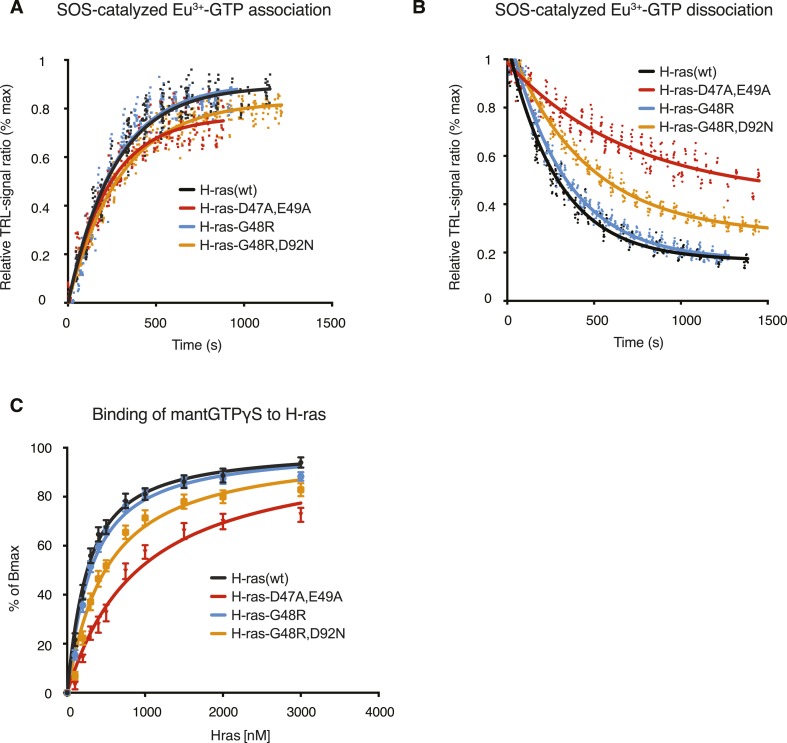
SOS-mediated nucleotide exchange kinetics, as well as mantGTPγS dissociation constants of wt H-ras and mutants.SOS-induced Eu3+-GTP association (A) and dissociation (B) kinetics with wt H-ras (black), H-ras-D47A,E49A (red), H-ras-G48R (blue), and H-ras-G48R,D92N (orange) monitored using the quenching resonance energy transfer (QRET) technique. Dots represent data points obtained from individual reactions, with a total of 360 individual data points for each H-ras. (C) Fluorescence anisotropy binding data for the derivation of dissociation constants (Kd) between mantGTPγS and wt H-ras (black), H-ras-D47A,E49A (red), H-ras-G48R (blue), and H-ras-G48R,D92N (orange). Details are described in the ‘Materials and methods’.